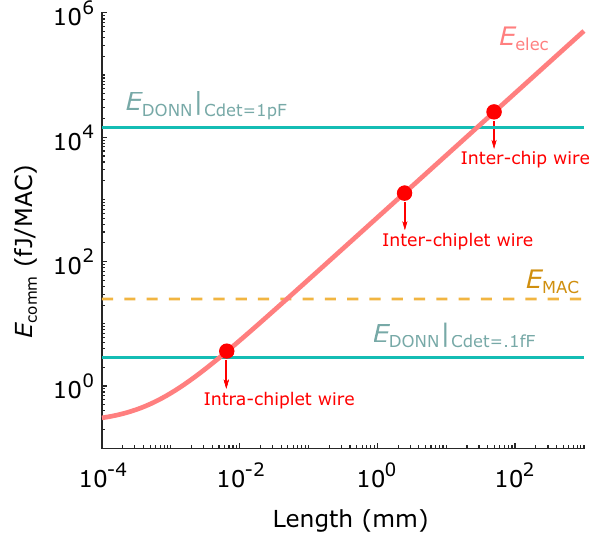
Figure 7. Energy required to transmit 16 bits (communication energy per 8-bit MAC, i.e., E comm ). Electronic data transfer energy ( E elec ) increases with wire length, whereas optical data transfer energy ( E DONN ) remains constant. Optical data transfer evaluated for two detector capacitances: C det = 1 pF for large, commercially- 3 available photodiodes 63 ; and C det = 0.1 fF for emerging receiverless, (1 µ m) -sized cubic detectors in modern CMOS processes 48 . Below C det = 0.1 fF, the capacitance of the overall receiver becomes limited by the capacitance of the CMOS inverter. Otherwise, the capacitance of the photodetector is energy-limiting. Energy of one 8-bit multiply-and-accumulate operation ( E MAC = 25 fJ/MAC) also shown for